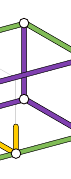
FIG. 14. The measurement pattern and check operator of a FBQC domain wall defect. Purple and green edges represent XX and ZZ operators. The extended edges are the measurements from next-to-nearest-neighbor fusions.